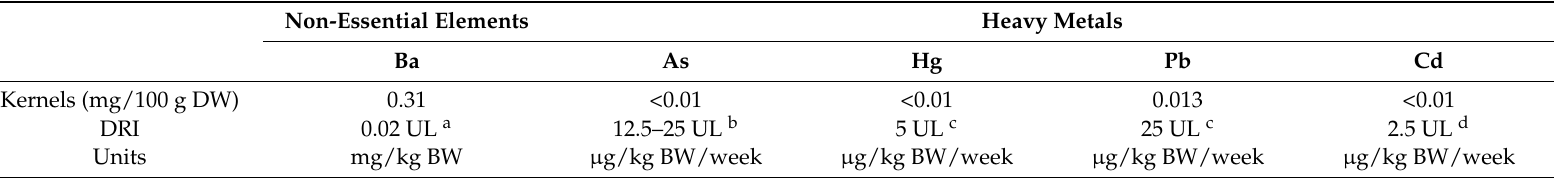
Table 4. Non-essential elements and heavy metal compositions of Terminalia ferdinandiana kernels (mg/100 g